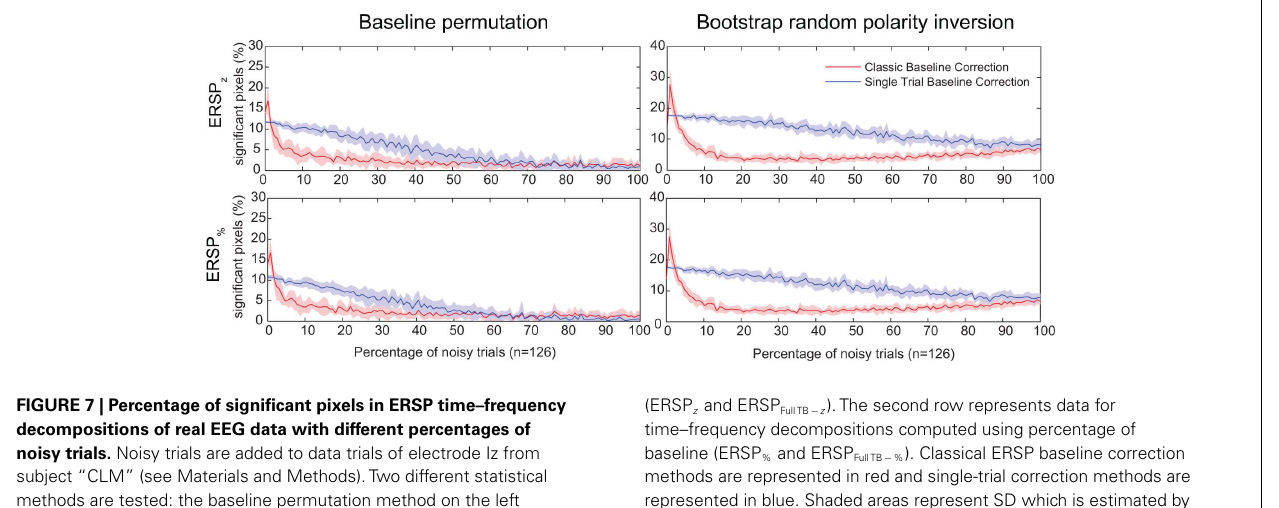
FIGURE 7 | Percentage of significant pixels in ERSP time–frequency decompositions of real EEG data with different percentages of noisy trials. Noisy trials are added to data trials of electrode Iz from subject “CLM” (see Materials and Methods).Two different statistical methods are tested: the baseline permutation method on the left column, and the bootstrap random polarity inversion method on the right column (see Materials and Methods).The first row represents data for time–frequency decompositions computed using z -score